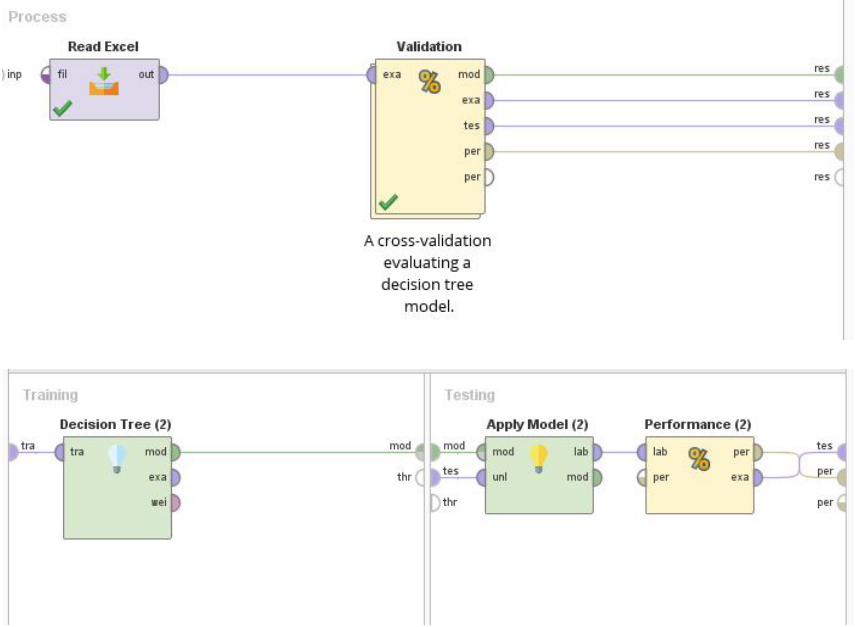
Fig. 8. Model Design Process